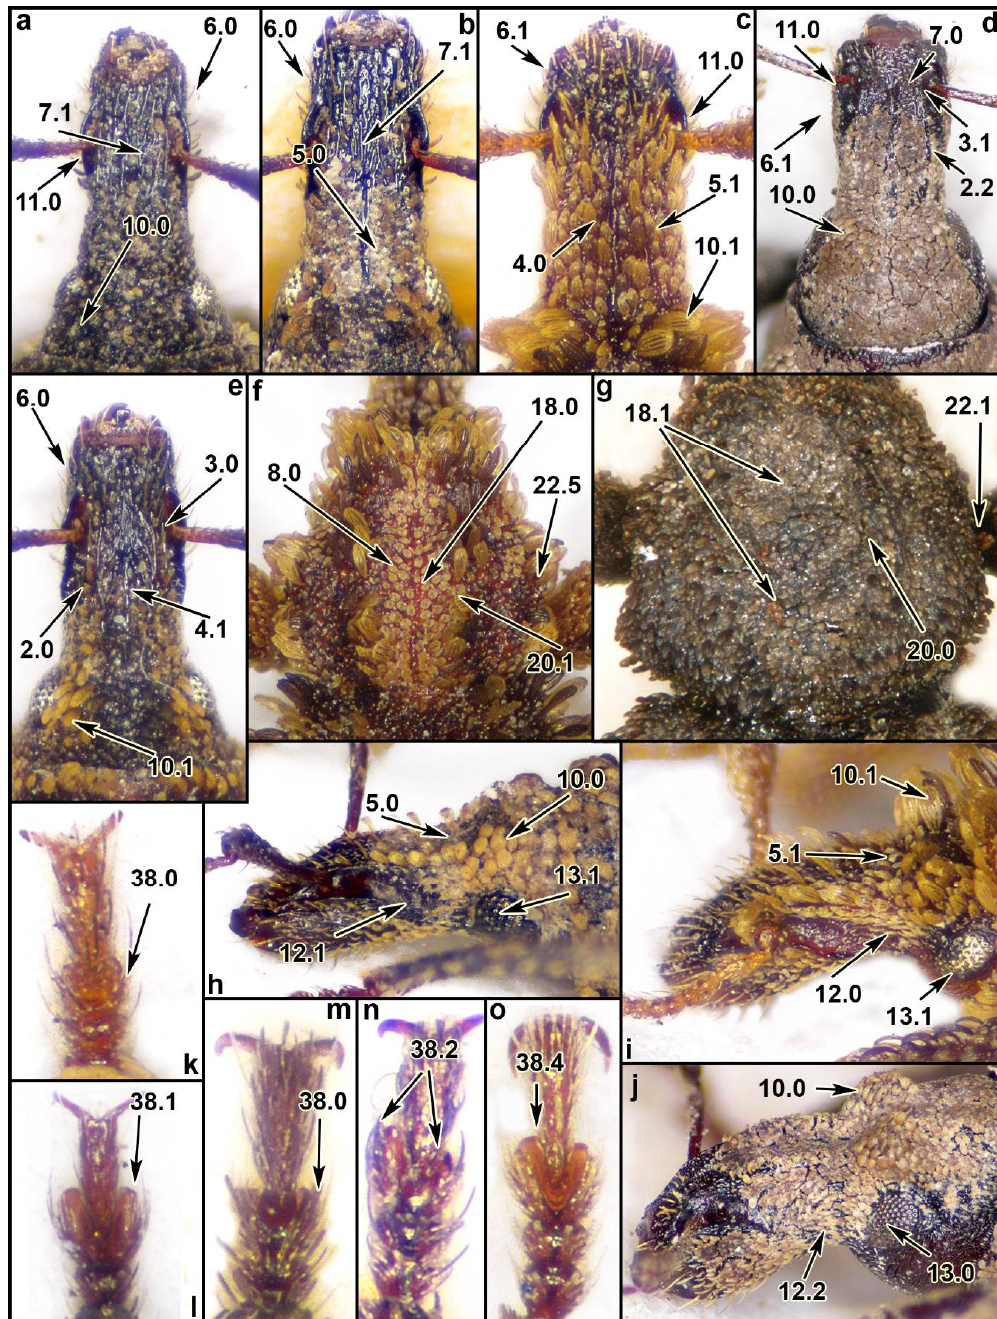
Figure 2. Rostrum, dorsal side, of Dichotrachelus augusti F. Solari ( a ); D. laurae Meregalli ( b ); D. baldensis Barajon ( c ); D. linderi (Fairmaire) ( d ); D.pericarti Osella ( e ). Rostrum, lateral side of D. rifensis Meregalli ( h ); D. baldensis ( i ); D. linderi ( j ). Pronotum of D. baldensis ( f ); D. sulcipennis Stierlin ( g ). Protarsus of D. baldensis ( k ); D. meregallii Osella ( l ); D. augusti F. Solari ( m ); D, negrei Gonzalez ( n ); D. rifensis ( o ). Not in scale.